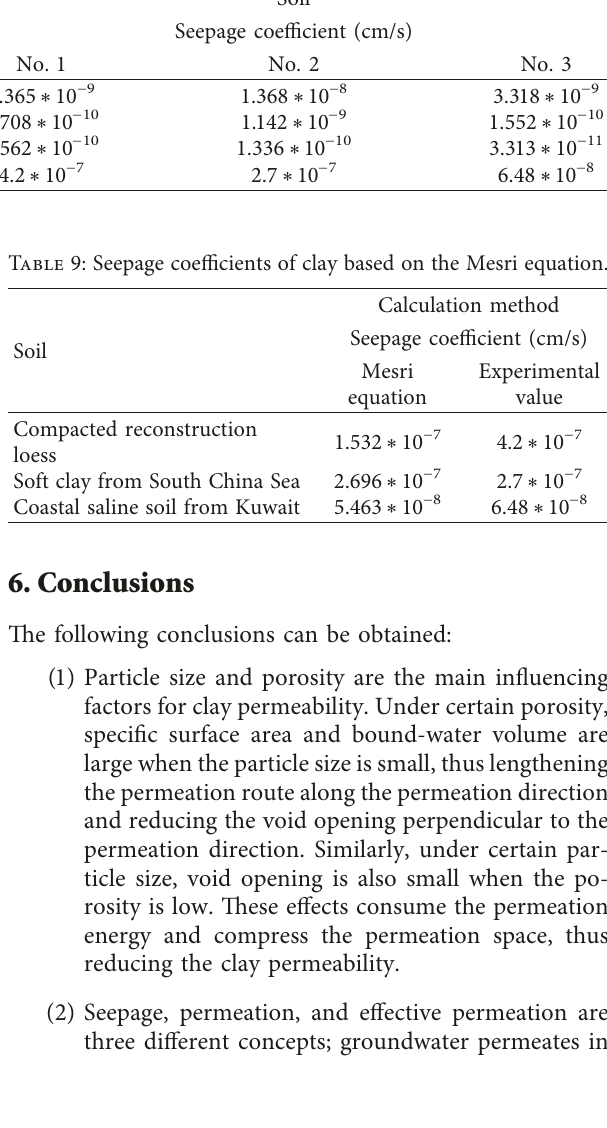
Table 8: Seepage coefficients of KC under different methods. Calculation methods